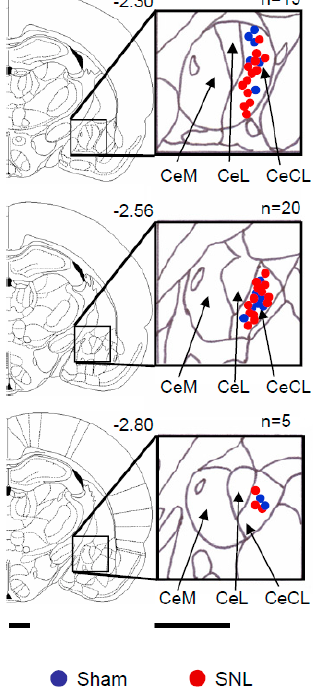
Figure 1. Histologically verified recording sites of 44 neurons in the central nucleus of the amygdala (CeA). The boundaries of the different amygdala nuclei were easily identified under the microscope. Diagrams show the central nucleus and its medial (CeM), lateral (CeL), and latero-capsular (CeLC) subdivisions in coronal sections at di ff erent levels posterior to bregma ( − 2.30 to − 2.80). Symbols show the positions of the tips of recording electrodes in the CeA based on electrolytic lesions (see the materials and methods section) in spinal nerve ligation (SNL) (red) and sham (blue) rats. Scale bars, 500 µm.